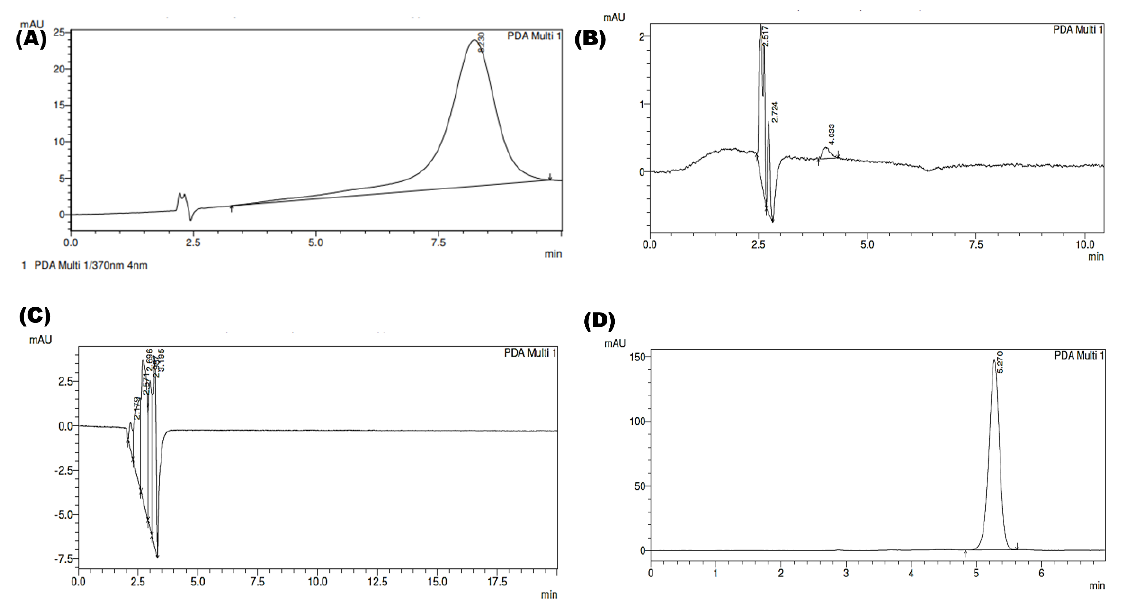
Figure 7. Depicting the chromatograms of ( A ) blank compritol E ATO ( B ) blank pluronic F 68